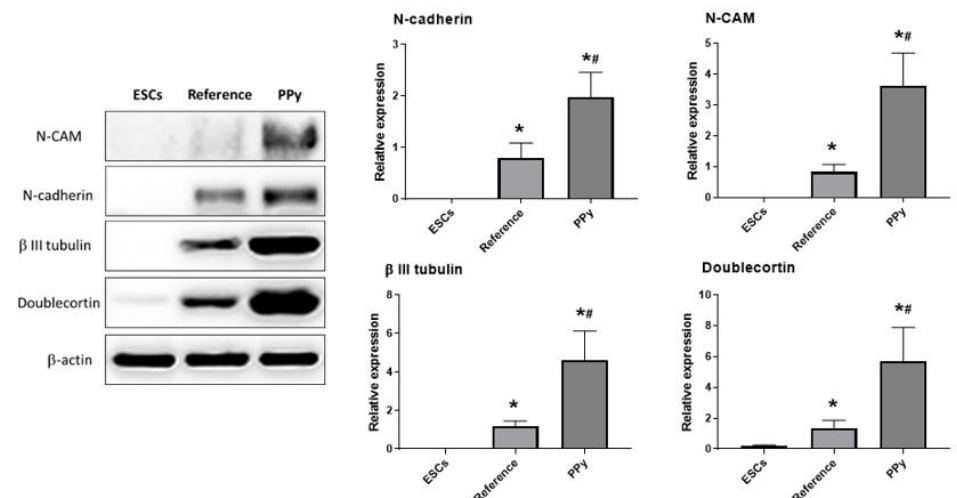
Figure 6. Western blot assay of the expression of neuron-specific proteins N-cadherin, N-CAM, β-III-tubulin, and doublecortin in non-differentiating ESCs and in differentiating ESCs with PPy treatment (PPy) and without PPy treatment (Reference) on day 16 of differentiation. The level of β-actin was used as a control of protein loading. Data are reported as the mean and standard deviations from a minimum of four independent experiments. Statistical significance was determined by ANOVA with post hoc Tukey’s Multiple Comparison test; * p < 0.05. (*) and (#) mark statistically significant differences compared to ESCs and to Reference, respectively.